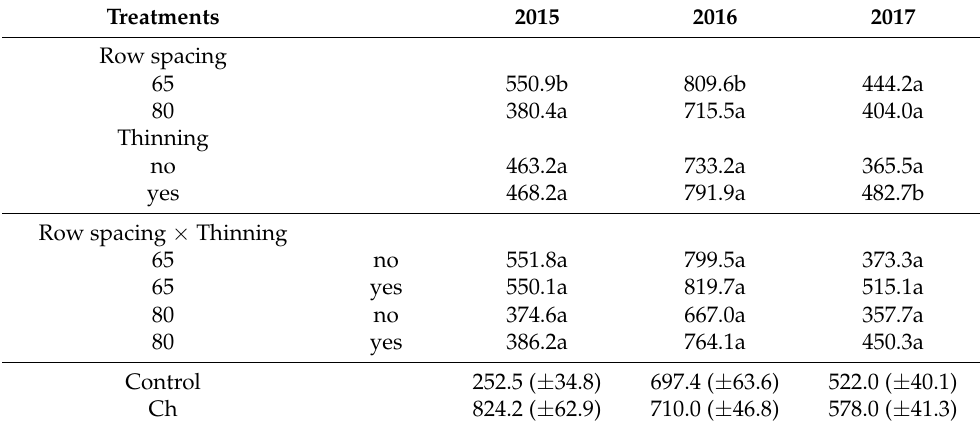
Table 7. Broad bean seed yield [g m − 2 ] in the 2015–2017